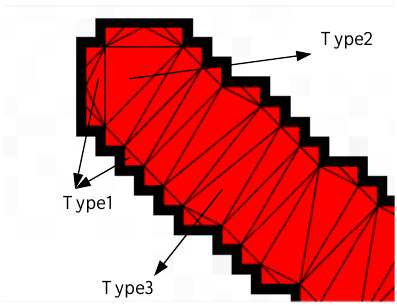
Figure 5. Triangle mesh of a star strip.